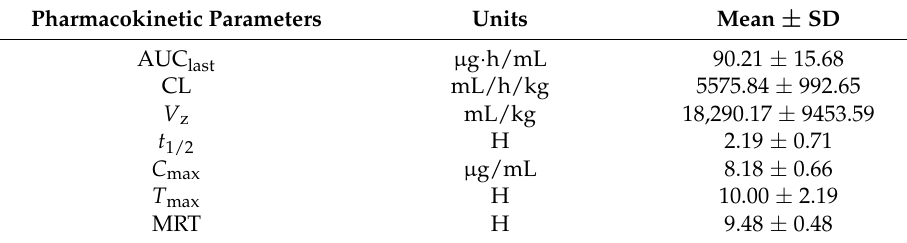
Figure 5. Plasma concentration-time profiles of Oxy-Di-OA after oral administration (mean ± SD, n = 6). Table 6. Main pharmacokinetic parameters of Oxy-Di-OA in rats.